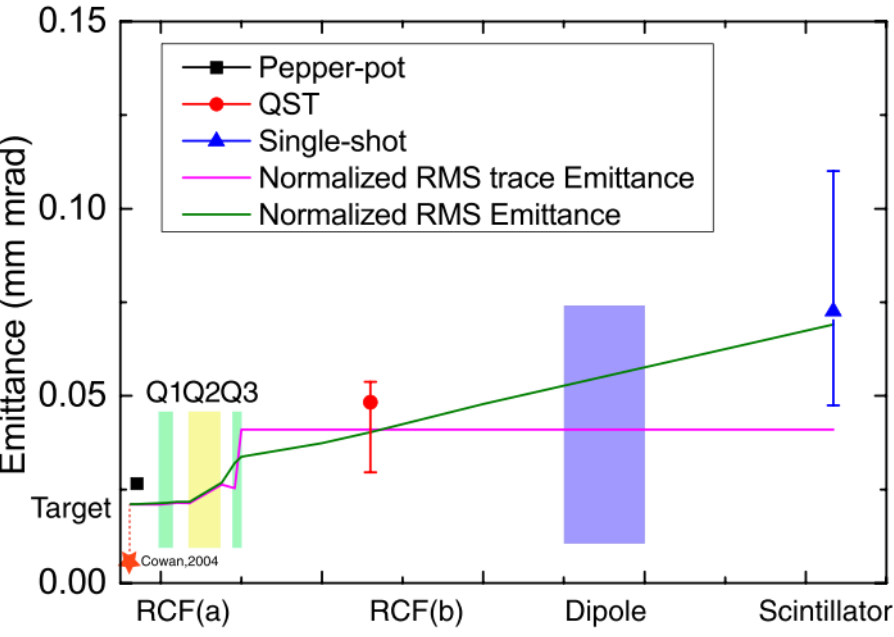
Figure 4. Emittance values from simulations and experiments. The solid lines are the emittance evolution during transport in simulations. The points with error bars are experimental results.